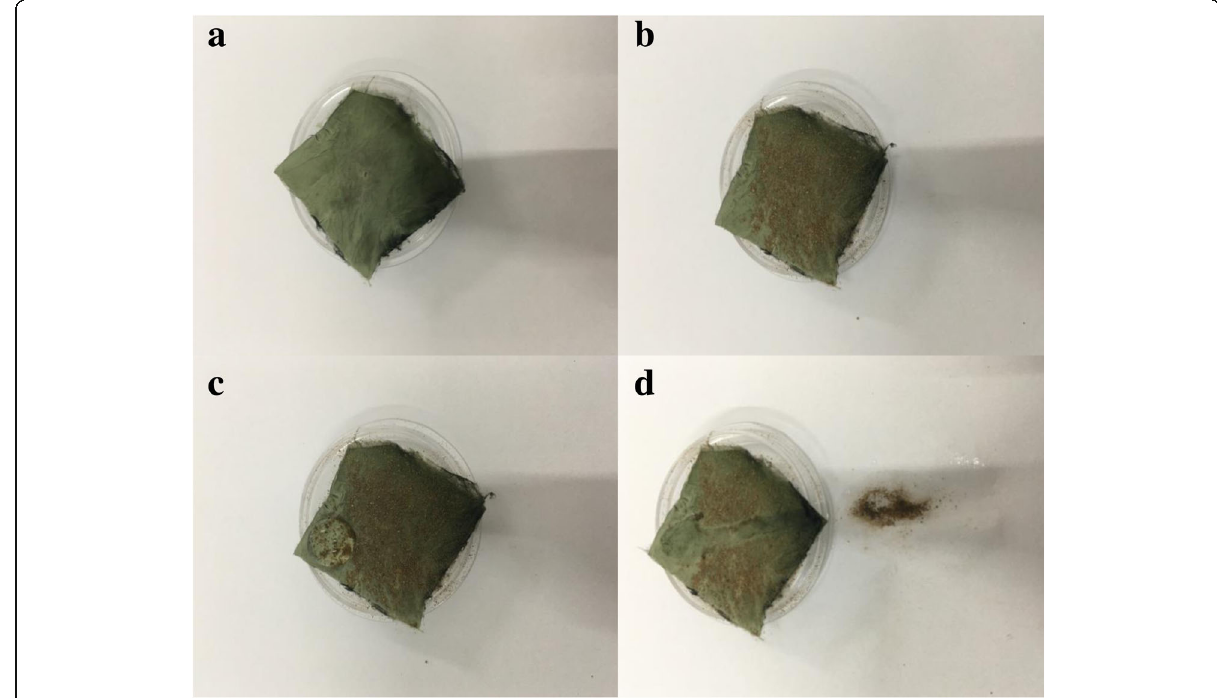
Fig. 11 The optical photograph of a water drop rolling on the surface of Cu 1 to remove dust: a clean sample, b sample with dusty surface, c drop droplets on dust-covered samples, and d the droplets roll away the dust and expose the clean surface of the